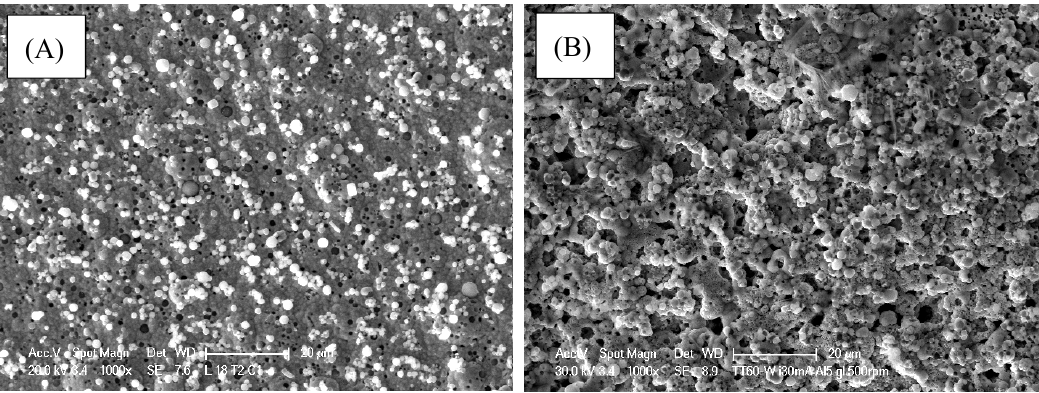
Figure 2. Surface morphologies of coatings obtained at the current density of 30 mA/cm 2 , Al content in the solution of 5 g/L, stirring rate of 500 rpm, and different temperatures: ( A ) 40 and ( B ) 60 °C. Surface roughness also affects the wear resistance of the material. Figure 1 shows the roughness values of the Ni-Mo/Al composite coatings obtained at different temperatures. As seen, the roughness of the composites shows the same behavior as the wear properties with increasing temperature. It is reduced and reaches a minimum at 40–50 °C, and then increases with a further increase in temperature. Higher roughness indicates the presence of agglomerates, which is confirmed by SEM image. A higher roughness causes the particles to be removed from the coating during the wear test. The resulting surface roughness increases the friction coefficient that leads to the loss of much more weight of coatings [21,22]. The microhardness values of Ni-Mo/Al composite coatings are also shown in Figure 1. The microhardness of the Ni-Mo/Al composite coatings increases up to 471 HV at 50 °C and then decreases to 345 HV with a further increase in temperature. The results suggested that the weight loss was declined with the rise of the hardness and decrease of the roughness. These results show that there is a relation between roughness and hardness with wear resistance. This achievement was approved by some references [6,23–26]. Narasimman et al. [23] confirmed that the weight loss of the coatings increased considerably with an increase in the surface roughness. Eslami et al. also reported that the grain sizes and microhardnesses of coatings are decreased and increased, respectively, by adding particles to the matrices of coatings [24,27]. According to the literatures, increasing the hardness of a coating can be related to the three reasons [28,29]: (1) the presence of a particle, (2) the distribution of a particle, and (3) the grain refining. The presence of a particle increases hardness when the particle is hard and its volume fraction is higher than 20%, and particle dispersion also increases hardness and strength when the size of the incorporated particle is fine (<1 µm) and its volume fraction is less than 15%. In this case, the Al particles are softer than the Ni matrix, so the load is not carried by the Al particles, and the particles cannot restrain the matrix deformation and hinder dislocation motion. Consequently, the first and second strengthening mechanisms cannot be accepted as the main strengthening mechanisms in this case. Susan et al. [30] reported the third strengthening mechanism of coatings by metallic particles. According to the proposed mechanism, if the particles are electrically conductive, they effectively become part of the cathode surface and can stimulate the nucleation sites, and they reduce the grain size of the coating. Based on this property, they claimed that when the Al particles are incorporated into a growing Ni matrix, new grains nucleate on the surface of the Al. The small grains produce a refined microstructure in comparison to a pure nickel coating deposited under similar conditions. The effect of temperature on the grain size of coatings was shown in Figure 1. An investigation of the surface morphology of a Ni/Al composite coating by Susan et al. [30] provided further evidence that the A1 particles act as sites for enhanced growth of the nickel deposit. Thus, it has been concluded that additions of A1 particles to the Ni matrix can produce hardening by a structural refinement mechanism. The existence of smaller grains hinders the dislocation motion, leading to an expansion in microhardness. Increasing the wear resistance by increasing the hardness, due to the reduction of grain size, has been often expressed by Archard’s